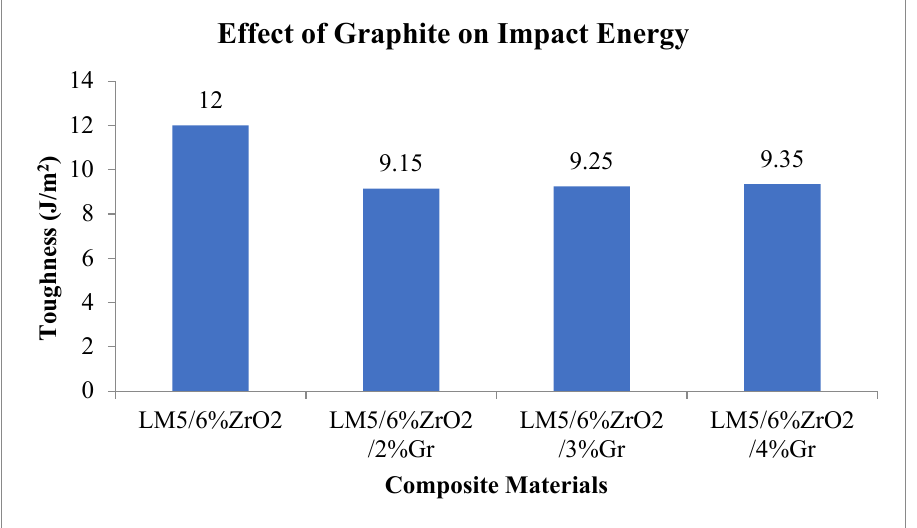
Figure 21. Effect of graphite on the toughness of composites.